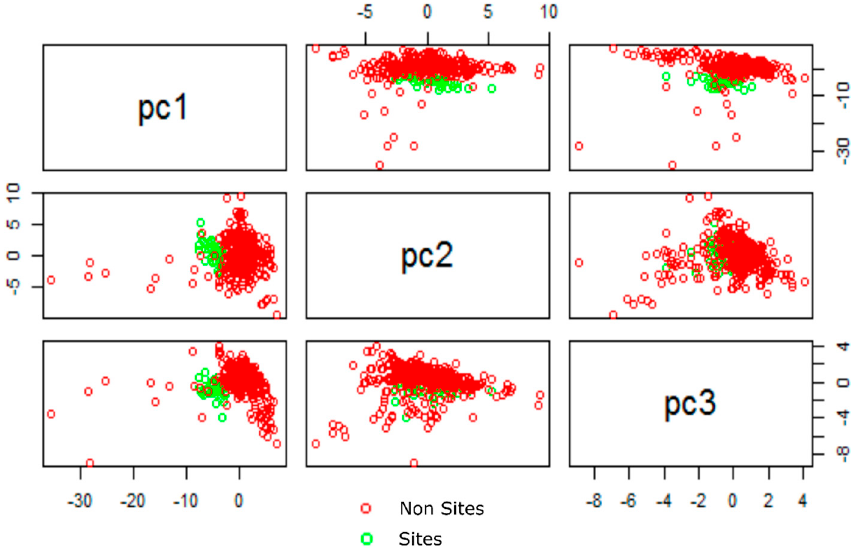
Figure 4. Pair Plots for Model 6 components 1, 2 and 3.